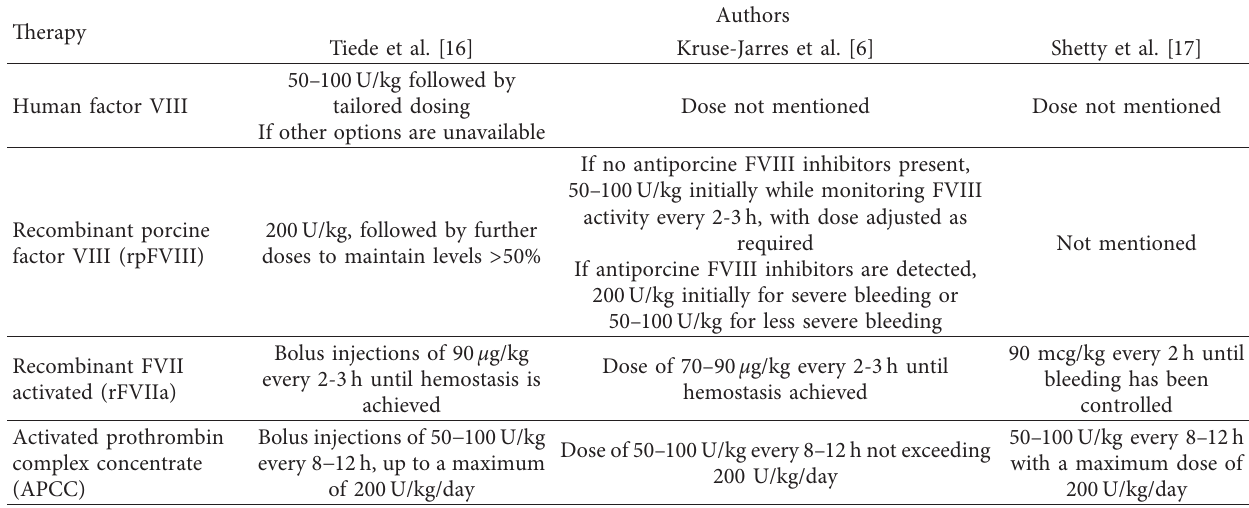
Table 1: Summary of hemostatic therapies found in the literature.